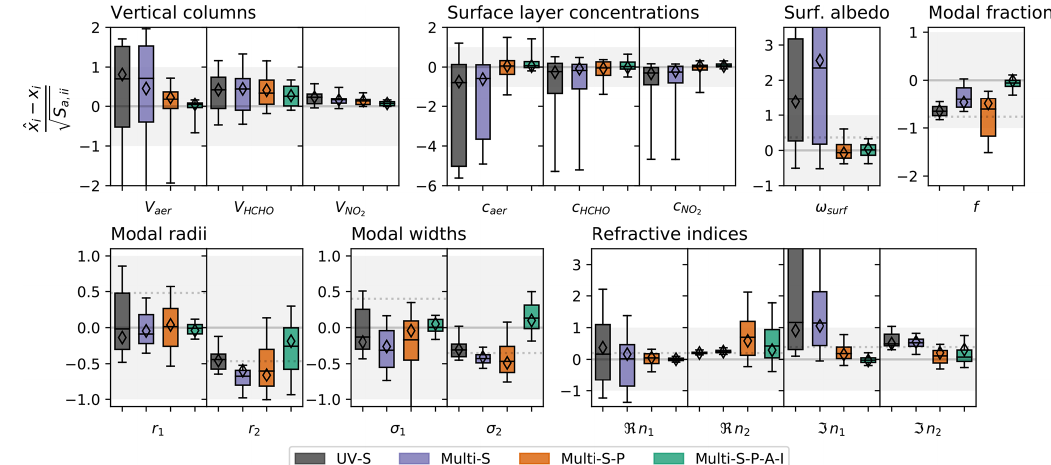
Figure 11. Statistical representation of all retrieval results, grouped by parameter (different subplots) and different measurement modes (box colours according to the legend). The y axis represents the difference to the true value, normalised by the a priori uncertainty. The latter is indicated by the grey shaded areas. Where possible, dotted grey lines indicate the a priori value. Deviations (cid:28) 1 with little bias towards the a priori indicate a successful retrieval. Boxes span the 25th to 75th, whiskers the 5th to 95th percentiles. Dashes indicate the median, and diamonds indicate the median of the retrievals from noiseless